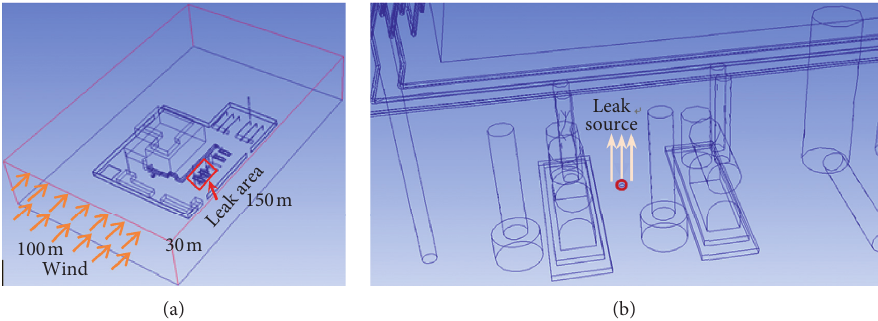
Figure 9: Schematic diagram of leakage scene. (a) The geometry of the injection station. (b) Location of the leak source.